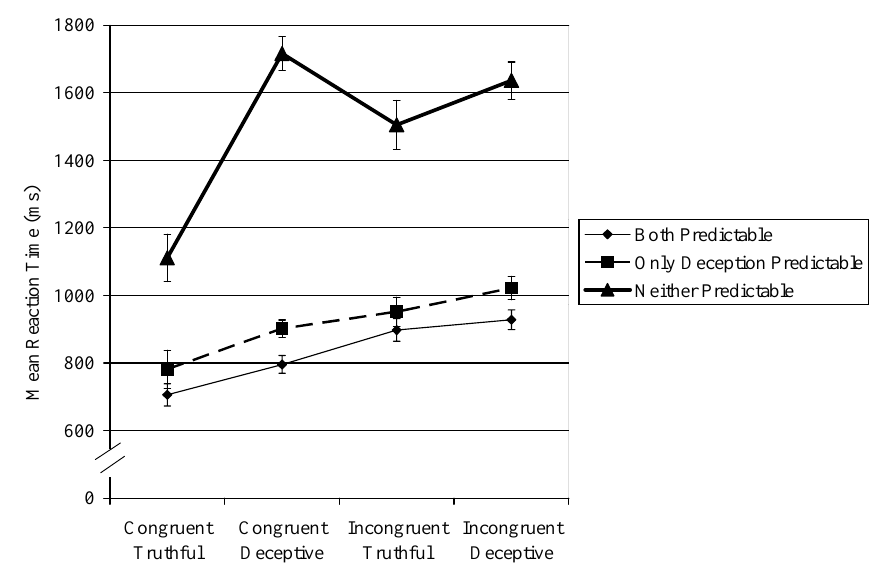
Fig. 8. Summary of mean reaction time scores across two-stimuli tasks with varying degrees of